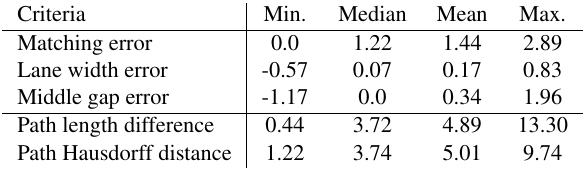
Table 1. Stage 1 (GPS) evaluation [m]